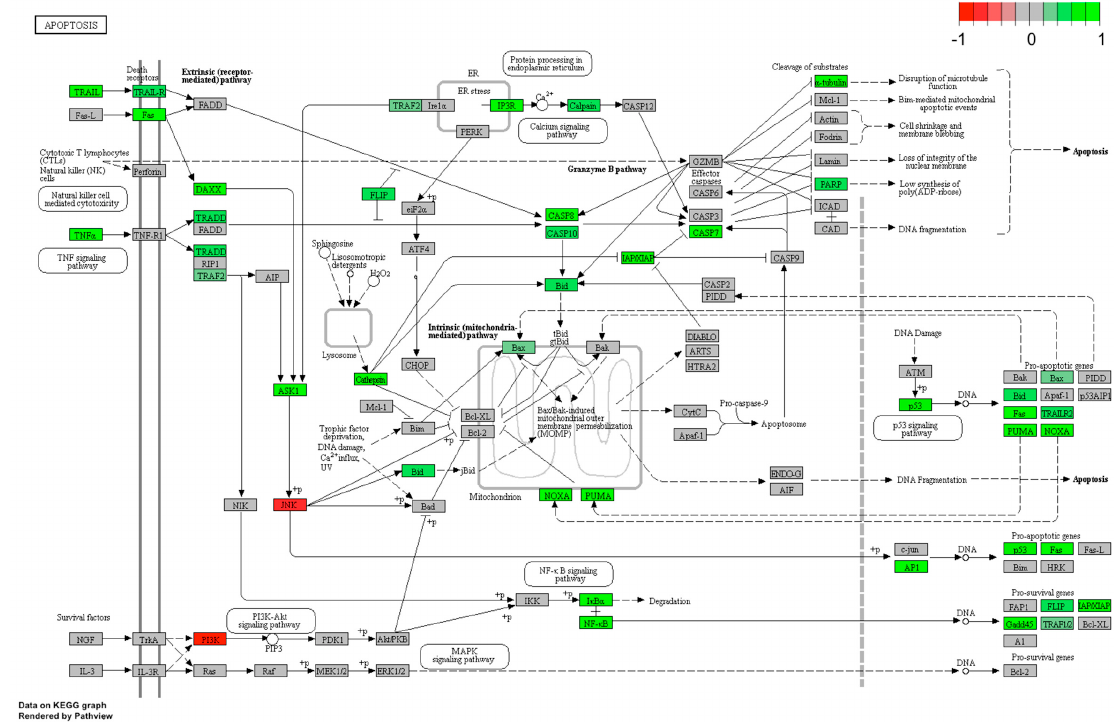
Figure 7. Apoptosis pathway in LNCaP cells treated with LEP (1 × 10 − ⁶ M). Expression changes of target genes are mapped by colours; green colour—statistically significant increase in expression, red colour—statistically significant decrease in expression, grey colour—expression statistically insignificant.